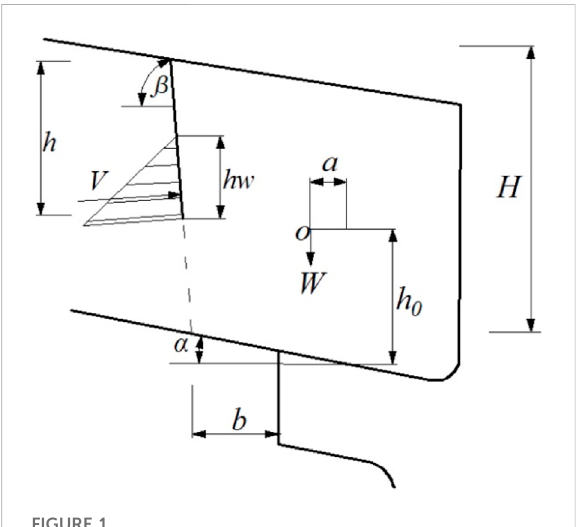
FIGURE 1 Force diagram of toppling dangerous